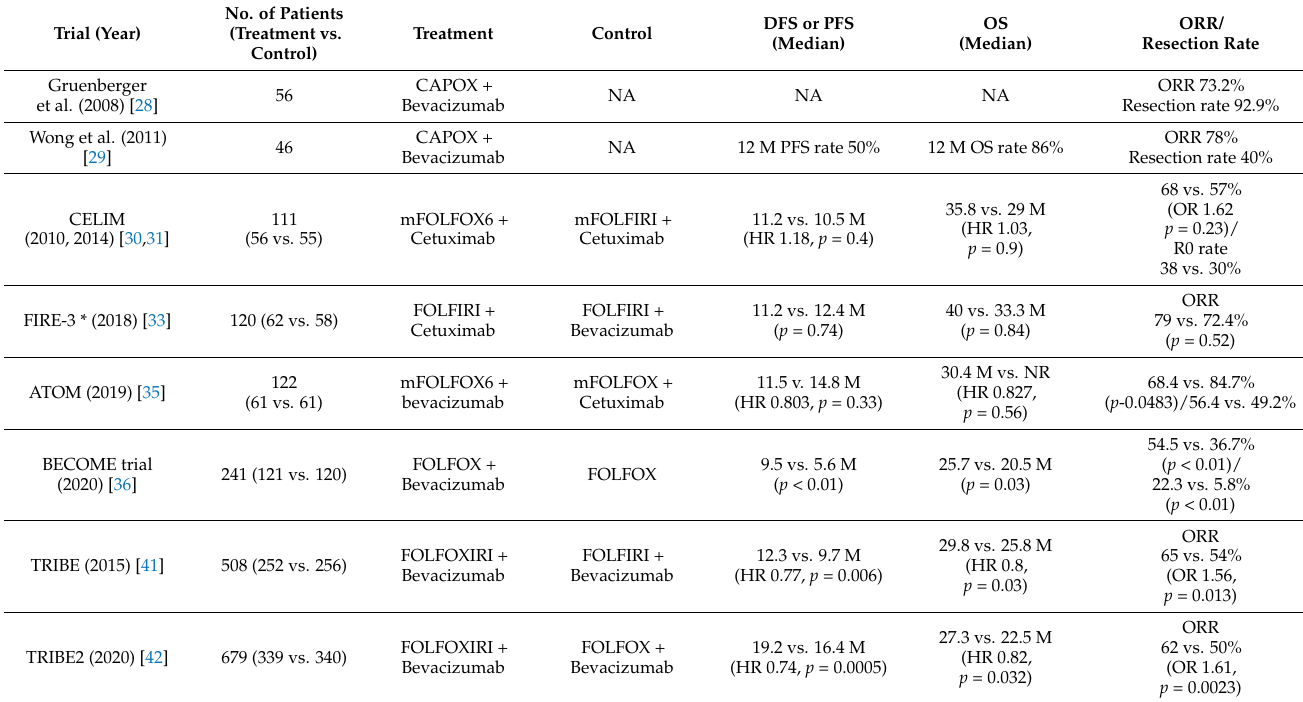
* Population of liver-limited disease in FIRE-3. Abbreviations: DFS: Disease-free survival; PFS: Progression-free survival; OS: Overall survival; ORR: objective response rate; CAPOX: capecitabine and oxaliplatin; FOLFIRI: 5-FU/LV and irinotecan; FOLFOX: 5-FU/LV and